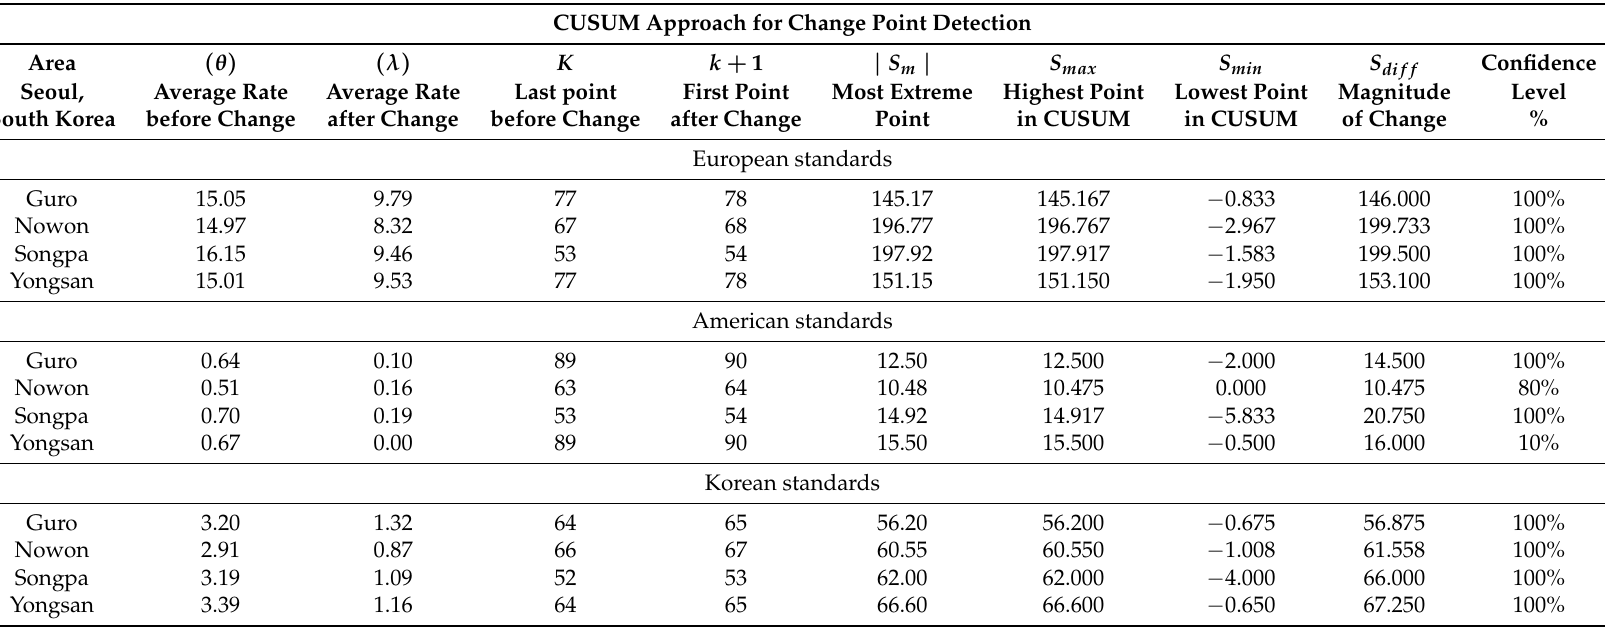
Table 14. PM 10 Last point before change ( k ) and First point after change ( k + 1) for European, American and Korean Standards through CUSUM